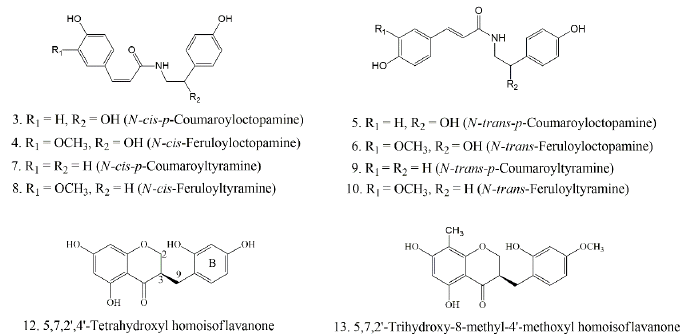
Figure 4. The potential ligands screened from the EA fraction of P. sibiricum by UF-LC-MS with superoxide dismutase (SOD) and xanthine oxidase (XOD).